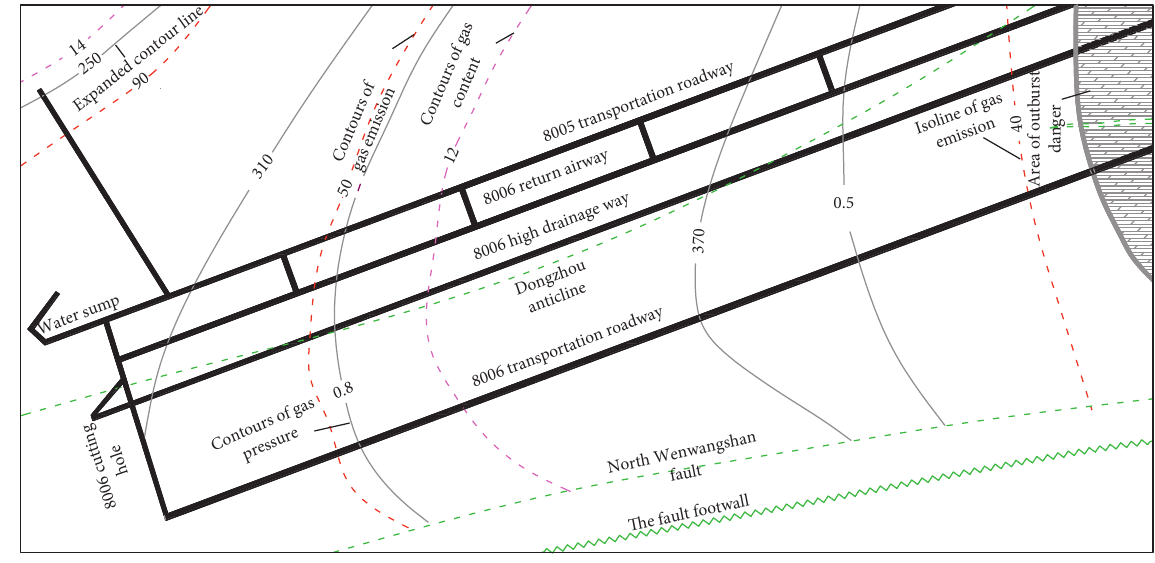
Figure 1: Geological structure map of test working face. Table 1: 3# geological parameters of gas in 3# coal seam.